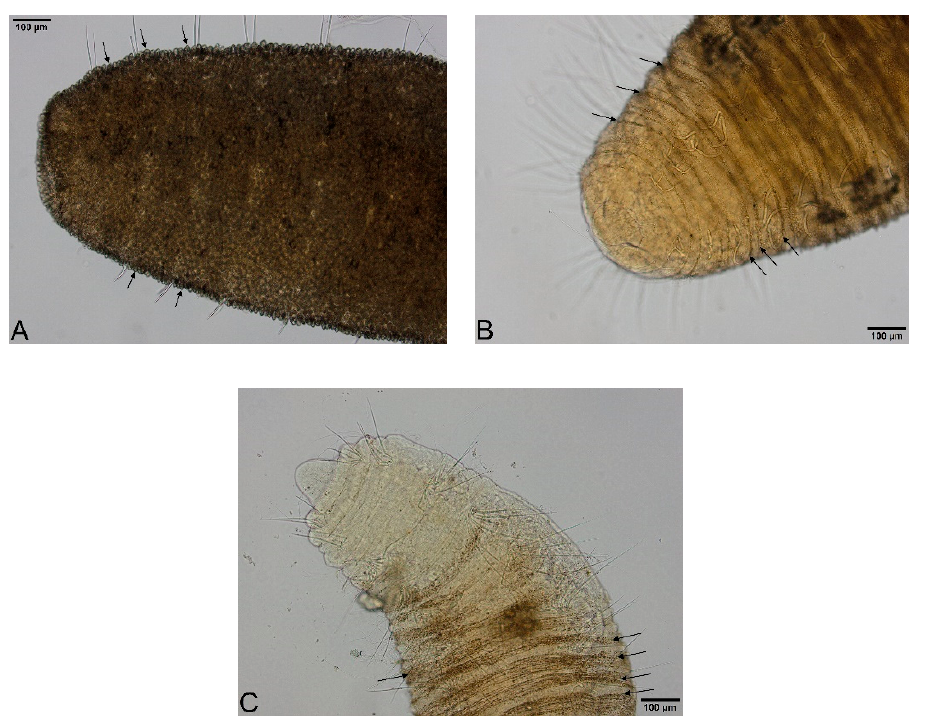
Figure 3. ( A ): Anterior part of Embolocephalus velutinus . ( B ): Anterior part of Spirosperma ferox . ( C ): Anterior part of Quistadrilus multisetosus . The arrows indicate some large dark and roundish particle aggregates in A and some transversal lines of small dark particle aggregates in B and C. Author: Régis Vivien.